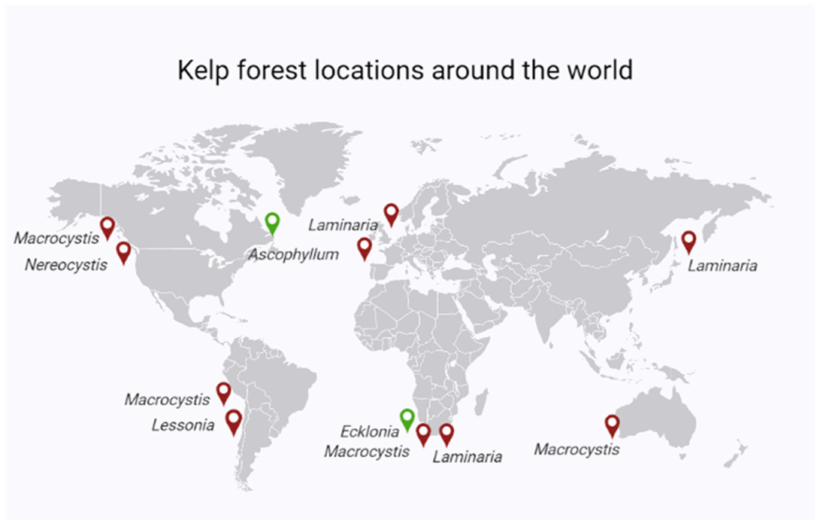
Figure 2. Location of the different kelp species forests around the world adapted from